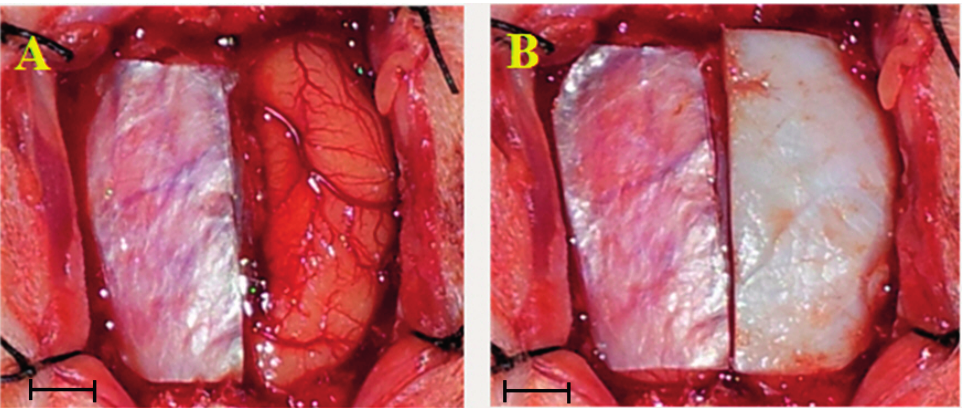
Figure 7. Craniotomies were performed and bilateral dura mater of rabbits were incised in oval shape with 25 mm × 10 mm dimensions. ( A ) Dura defects were patched by BC on the left side and without patching on the right side; and ( B ) Dura defects were patched by BC on the left side and NormalGEN ® on the right side. Scale bars = 5 mm in figure ( A , B